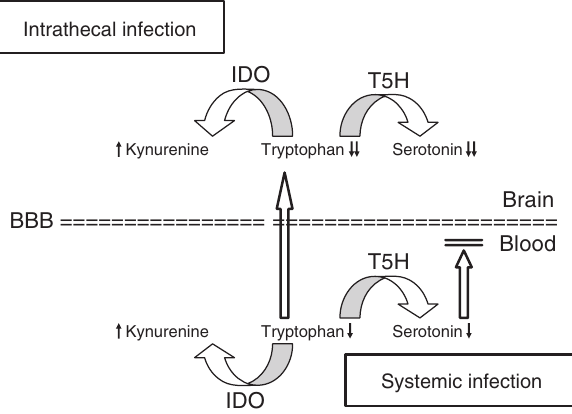
Figure 6 Cytokine-induced tryptophan breakdown is one impor- tant aspect for the increased susceptibility for depressive mood in patients suffering from chronic immune activation syndromes such as virus infections. In systemic infections (e.g., HIV-1 infection and sepsis), activation of indoleamine (2,3)-dioxygenase (IDO) results in low serum-free tryptophan concentrations, and accumulation of degradation products like kynurenine and quinolinic acid takes place in the peripheral blood. Low tryptophan levels diminish the availability and the biosynthesis of neurotransmitter